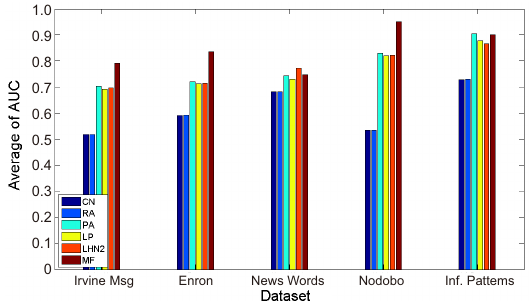
Fig. 2 AUC comparison for MF and other